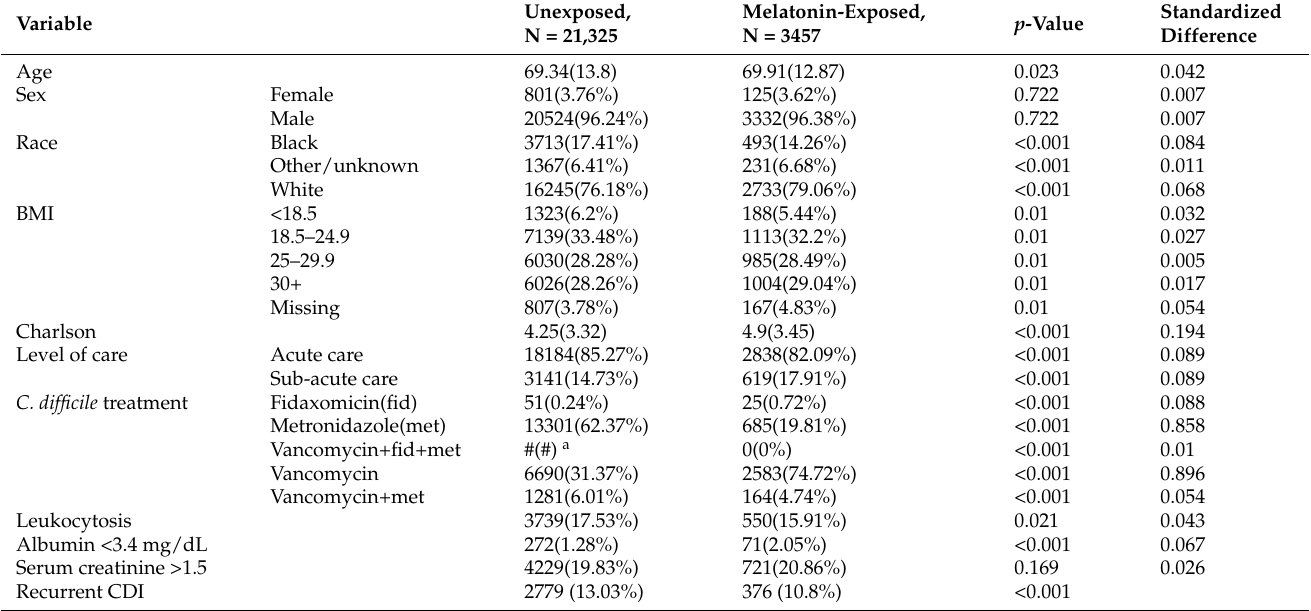
Table 1. Baseline Demographic and Clinical